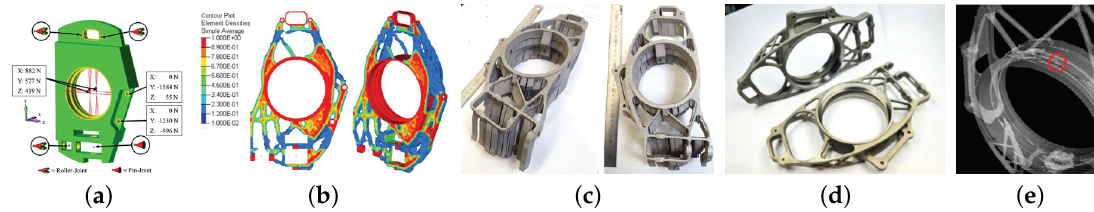
Figure 6. Engineering cycle of an AM part: ( a ) presentation of the design domain and boundary conditions; ( b ) density maps of TO, considering the threshold at 0.25; ( c ) AM part still with the support structures; ( d ) machined AM part; and ( e ) its X-Ray inspection